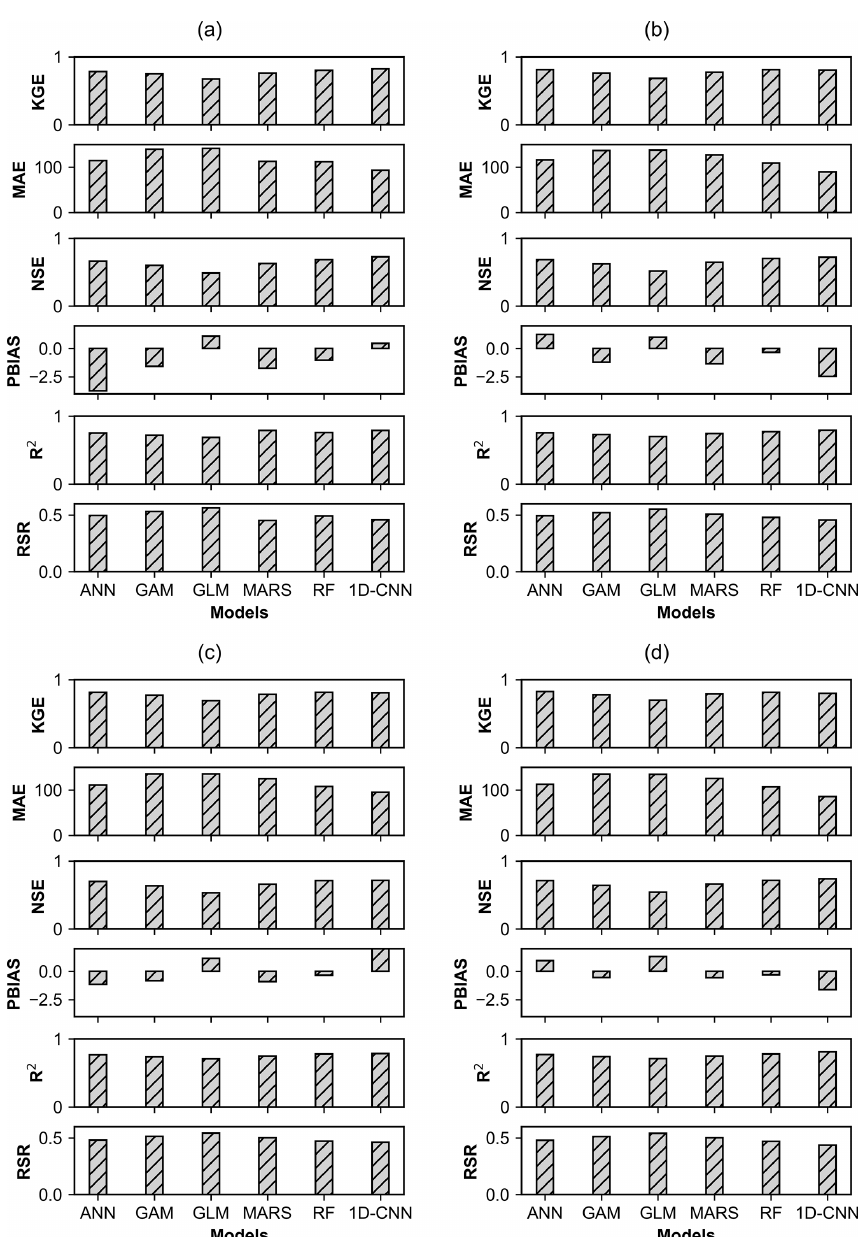
Figure 4. Evaluation of the models’ (ANN, GAM, GLM, MARSs, RF, and 1D-CNN) performance in simulating streamflow under rainfall scenarios (a) R 0 , (b) R 1 , (c) R 2 , and (d) R 3 at Kasol during the testing phase using six statistical metrics ( R 2 , KGE, NSE, RSR, MAE, and